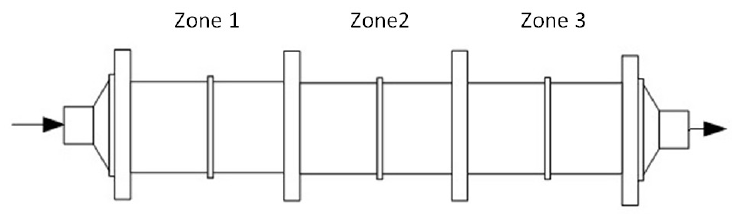
Figure 1. CSTR in-series model for a tubular rotary kiln.